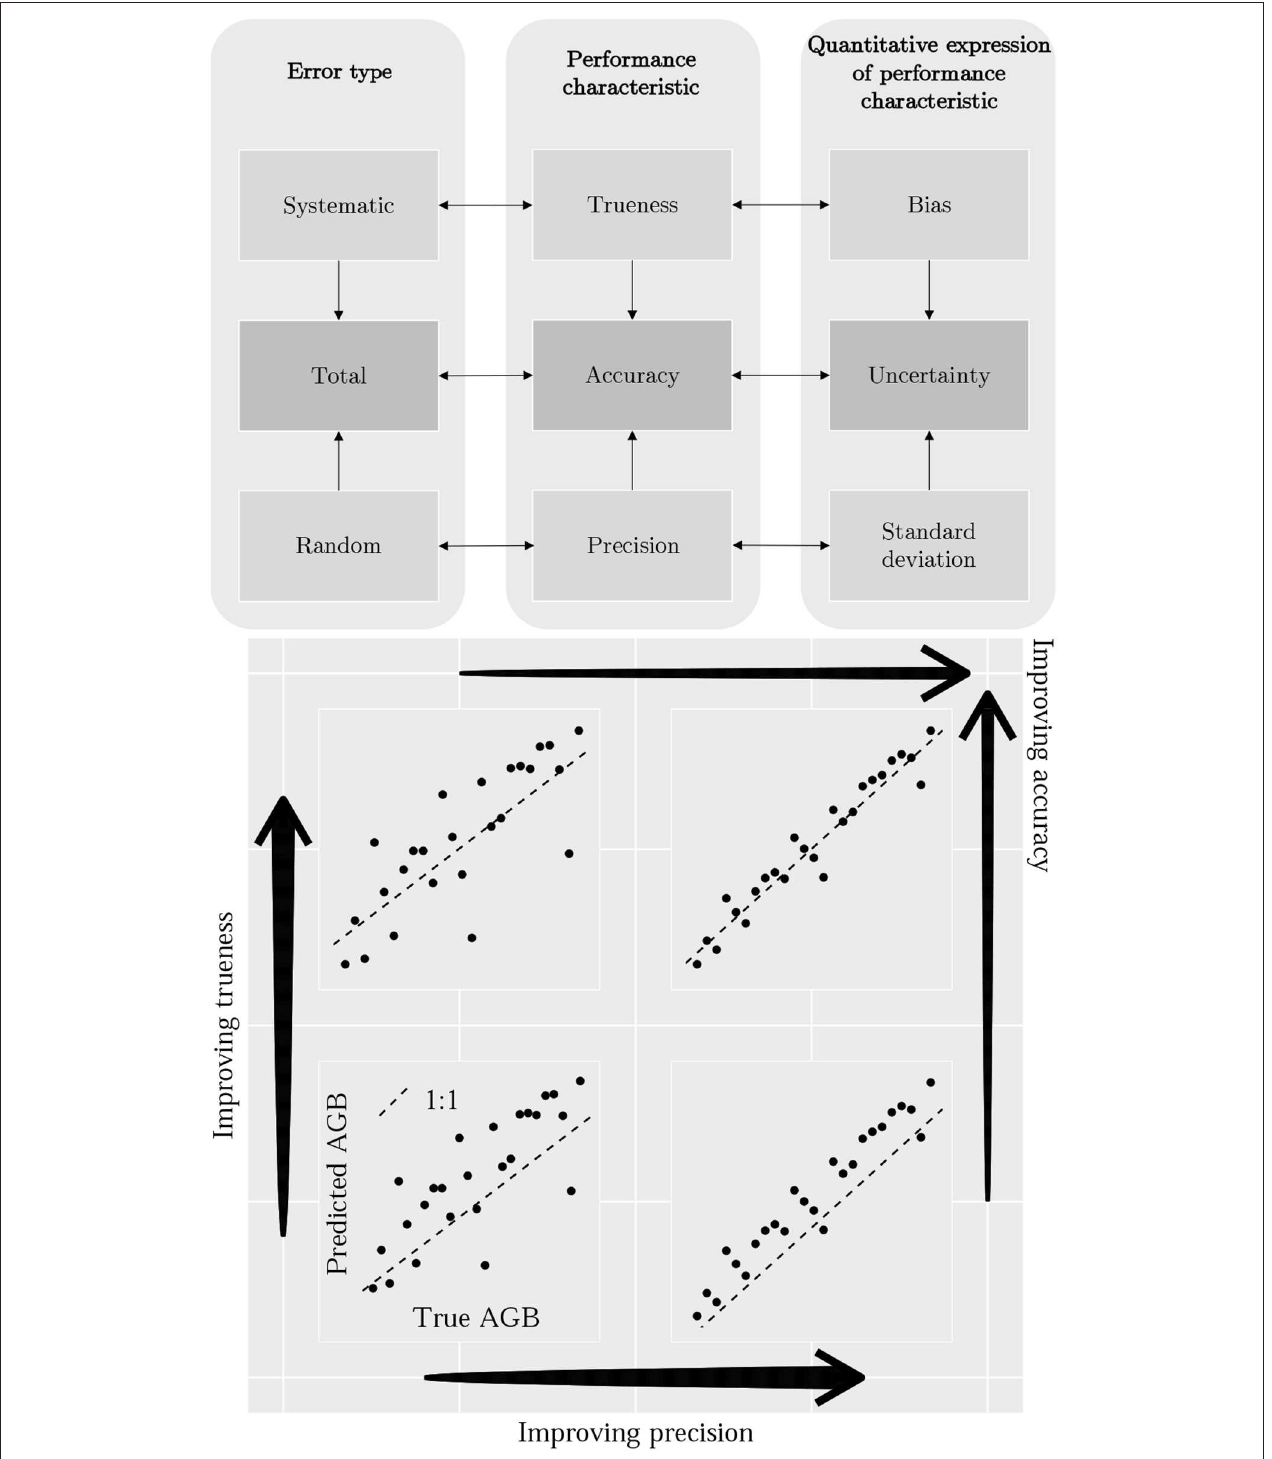
FIGURE 1 | Definition of the terms used in this paper to describe the concept of error in out-of-sample pan-tropical allometric AGB predictions (ISO 5727 and BIPM definitions) (ISO-5725-1:1994(en), 1994; JCGM-200:2012, 2012). The upper chart, adapted by permission from Springer Nature: (Menditto et al., 2007) defines the relationships between error type and associated performance characteristic. The lower plot illustrates the effect on predictions from improving trueness, precision, and accuracy.